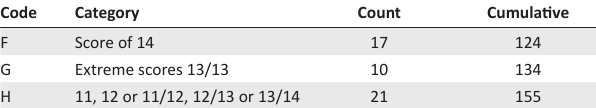
TABLE 11: Counts in further rank categories.